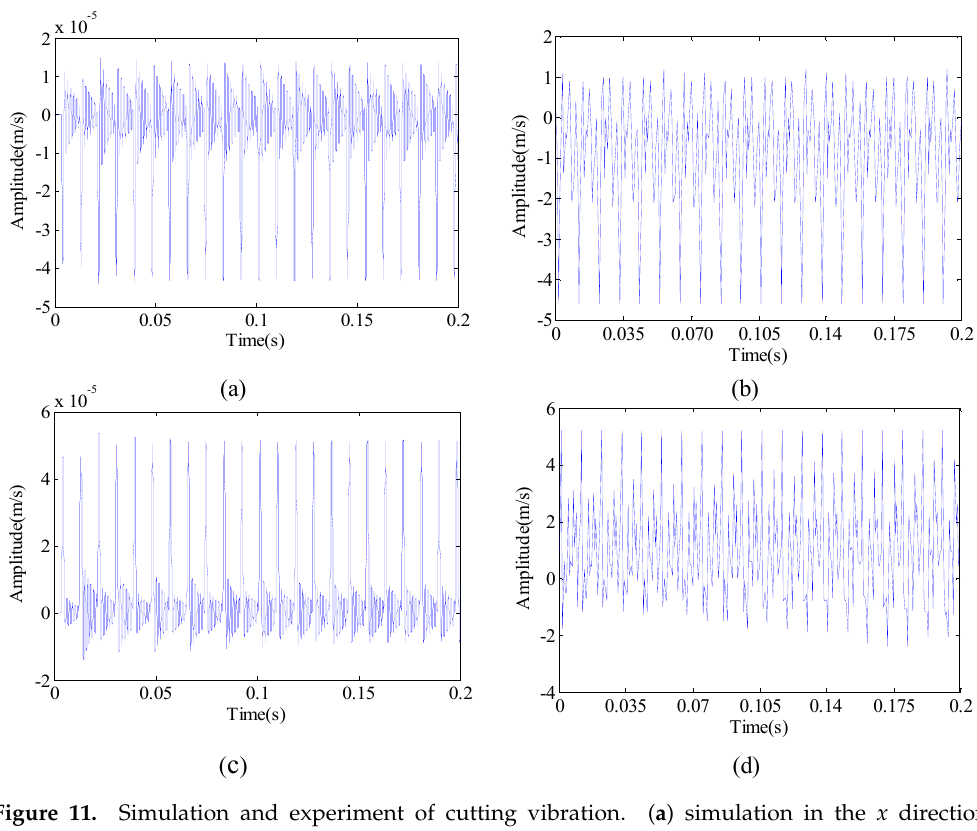
Figure 11. Simulation and experiment of cutting vibration. ( a ) simulation in the x direction; ( b ) experiment in the x direction; ( c ) simulation in the y direction; ( d ) experiment in the y direction.